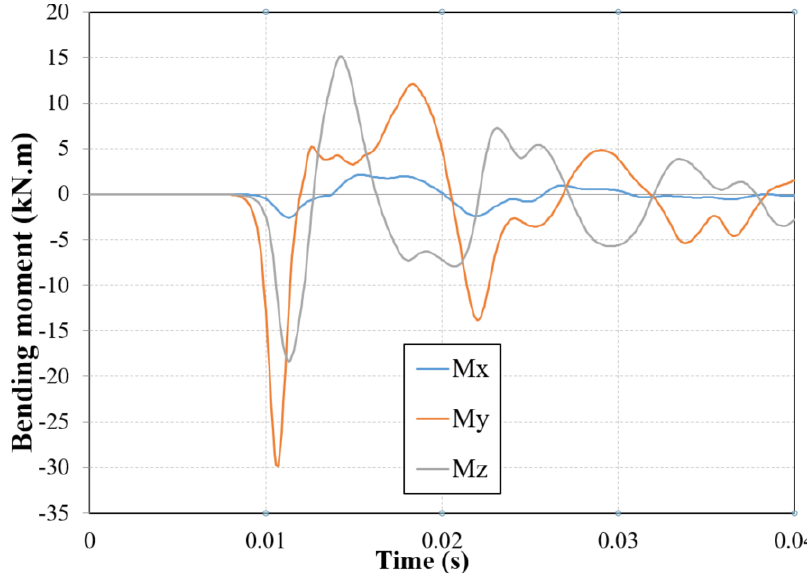
Figure 9. Components of bending moment acting on the obstacle at a distance of 5 m depending on time.